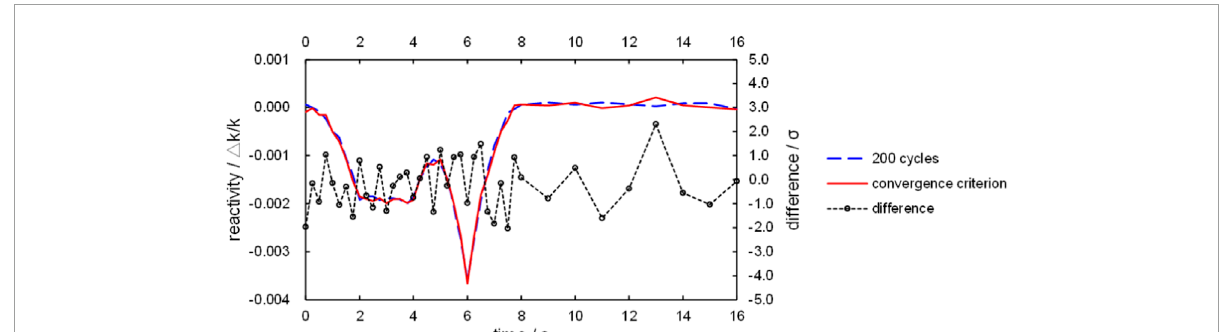
FIGURE 5 Comparison of reactivity profiles, obtained by setting 200 inactive cycles and using Eq. 28 .